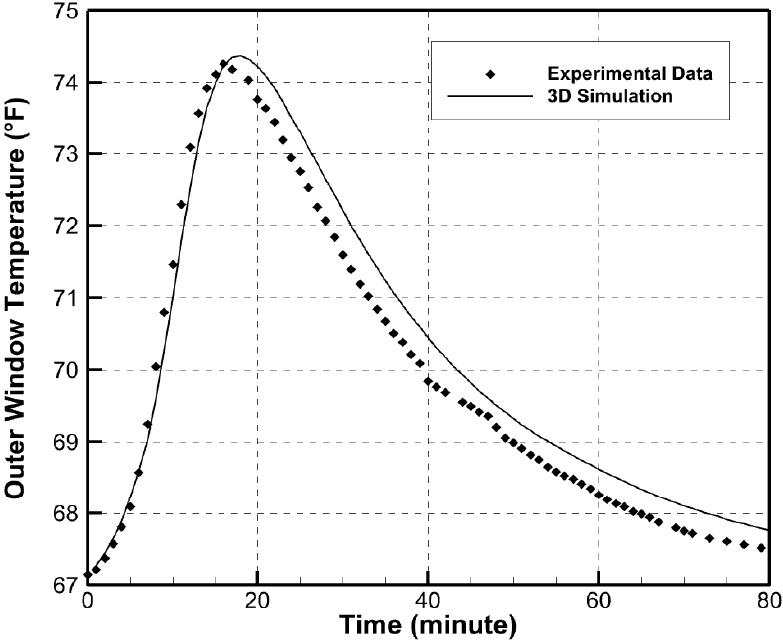
Figure 7. Comparison of simulation results to experimental results of Lumira ® aerogel window material.